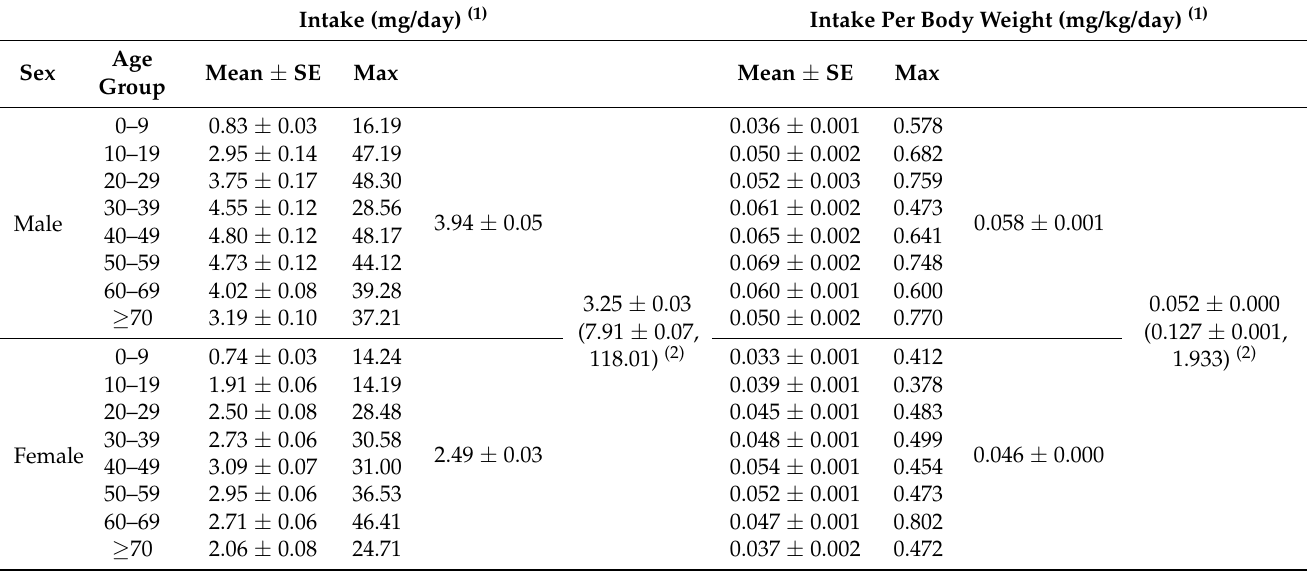
(1) Estimates based on the capsaicinoid content of red pepper powder with medium-hot intensity (59.1 mg/100 g); (2) Estimates based on the capsaicinoid content of red pepper powder with extremely hot intensity (153.8 mg/100 g). Mean ± SE: mean intake, Max: maximum daily